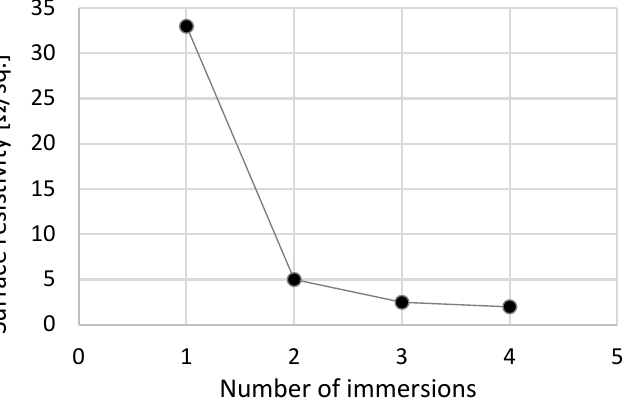
Figure 5. Plot of the dependence of the number of immersions of a nylon veil in a solution with nanowires on its surface resistivity (source: own work on the basis of [67]).